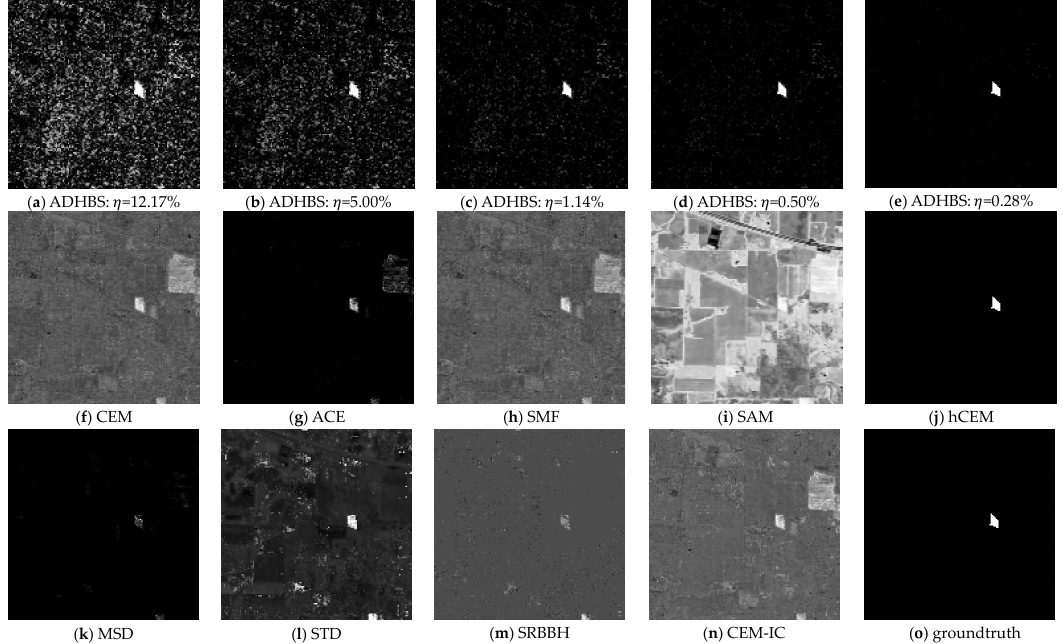
Figure 12. Detection results of the Indian Pines data. ( a–e ) the results of the proposed ADHBS method in different layers, corresponding to different degrees of background separation. ( f - n ) the results of CEM, ACE, SMF, SAM, hCEM, MSD, STD, SRBBH, and CEM-IC, respectively. ( o ) the ground truth of the